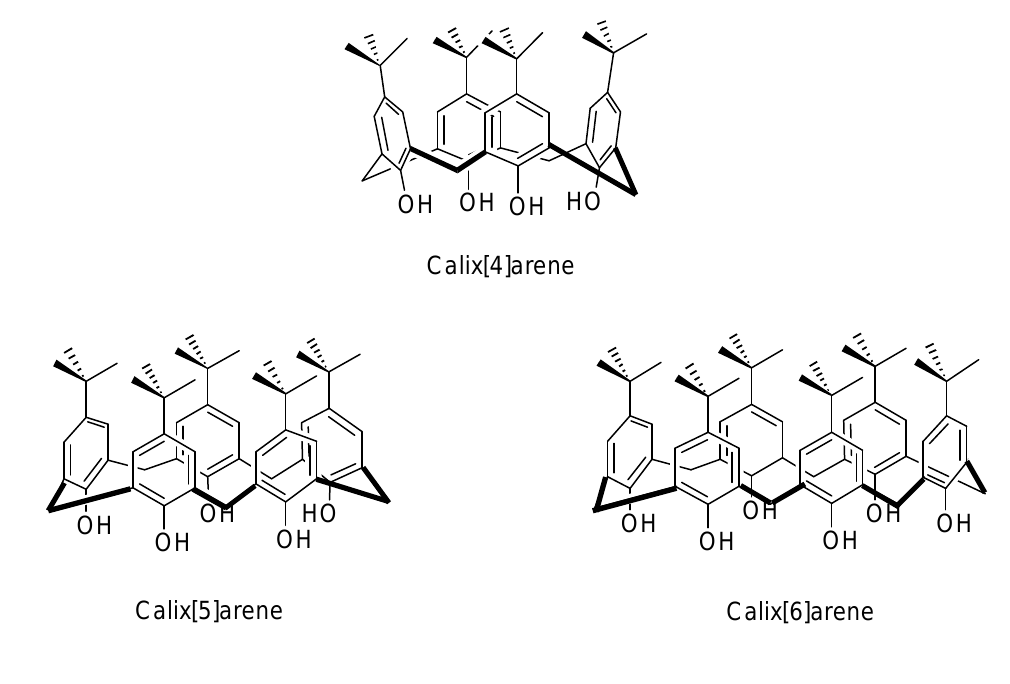
Figure 3. Four different conformations of